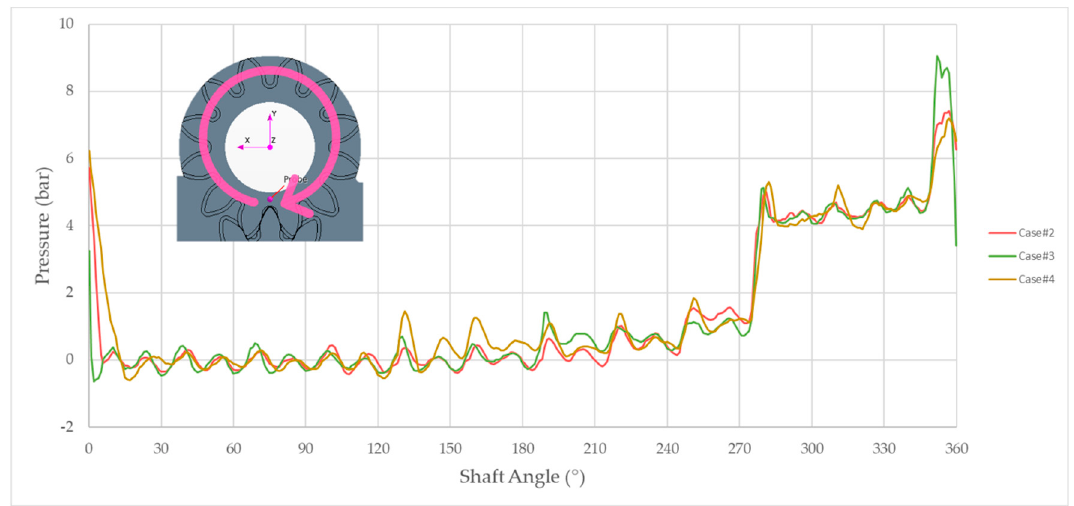
Figure 23. Pressure within the axial gap of the pump during an entire revolution of the driving shaft for Case #2, Case #3, and Case #4.